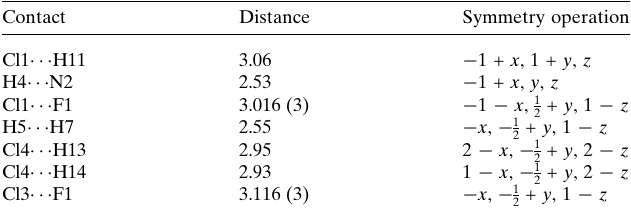
Table 2 Summary of short interatomic contacts (A˚ ) in the title compound. Contact